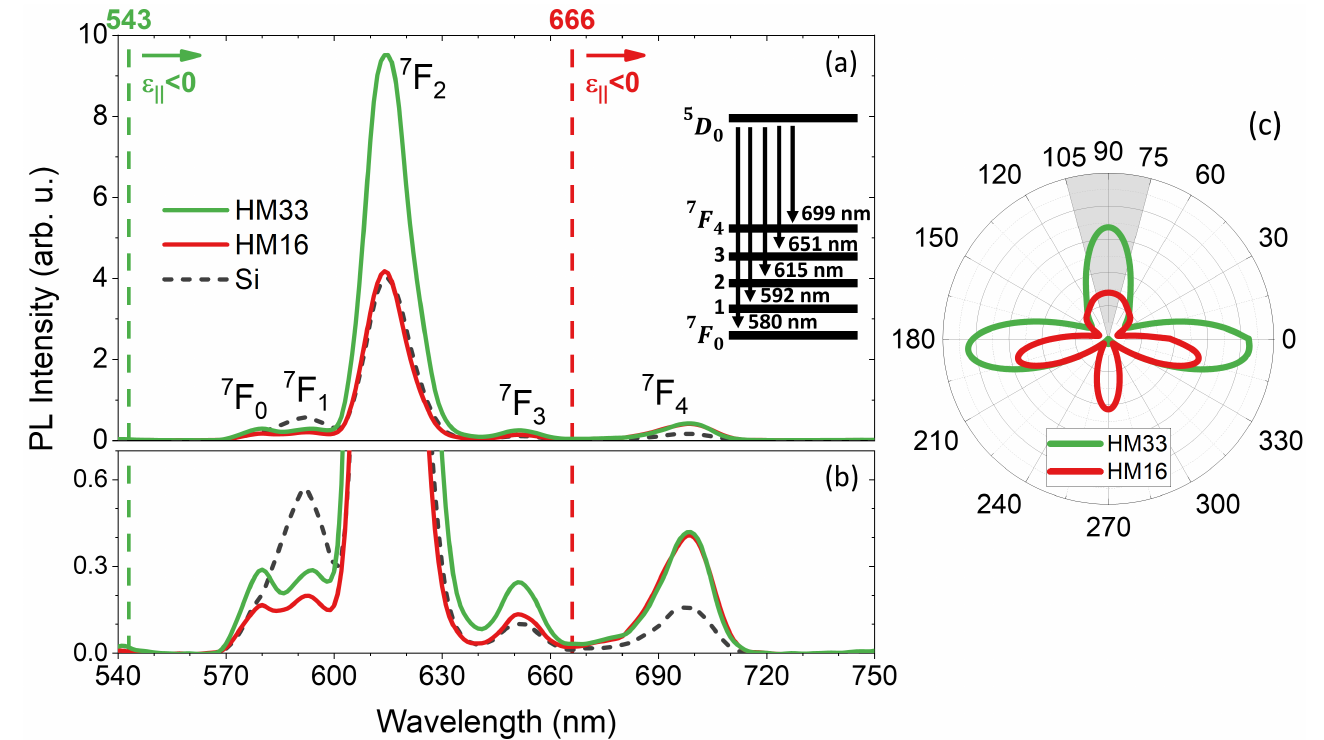
Figure 2. ( a ) Photoluminescence spectra of Eu 3+ embedded in a PMMA thin film deposited on the hyperbolic multilayers and the reference Si substrate, all having a 10 nm spacer on top. The vertical dashed lines indicate the ENZ wavelength of each metamaterial and the arrows indicate the spectral region of their hyperbolic regime. Inset: energy-level diagram of the Eu(TTA) 3 radiative decay channels between the excited state 5 D 0 and the 7 F J levels. ( b ) Magnification of the less intense radiative transitions. ( c ) Angular distribution of far-field irradiance (in W/m 2 ) at λ = 615 nm simulated by COMSOL for an emitting electric dipole in close proximity of HM33 (green) and HM16 (red) with a silica spacer (10 nm) on top. The gray area indicates the collection angle of our